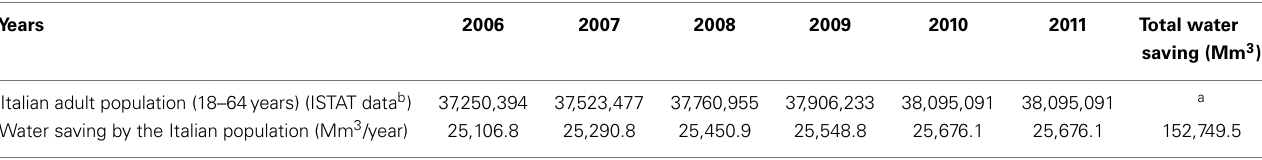
Table 8 |Water saving assuming a 100% adherence of the Italian population to the proposed Mediterranean diet during the last 6years (from 2006 to the end of 2011) (in million cubic meters – Mm 3 )